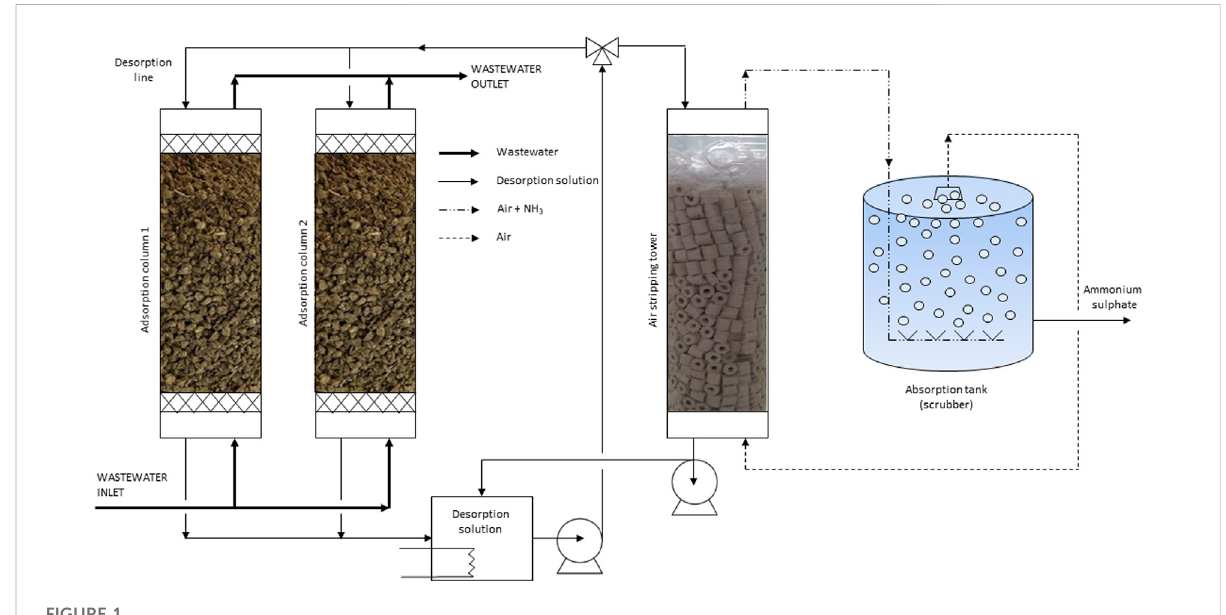
FIGURE 1 Schematic diagram of the experimental